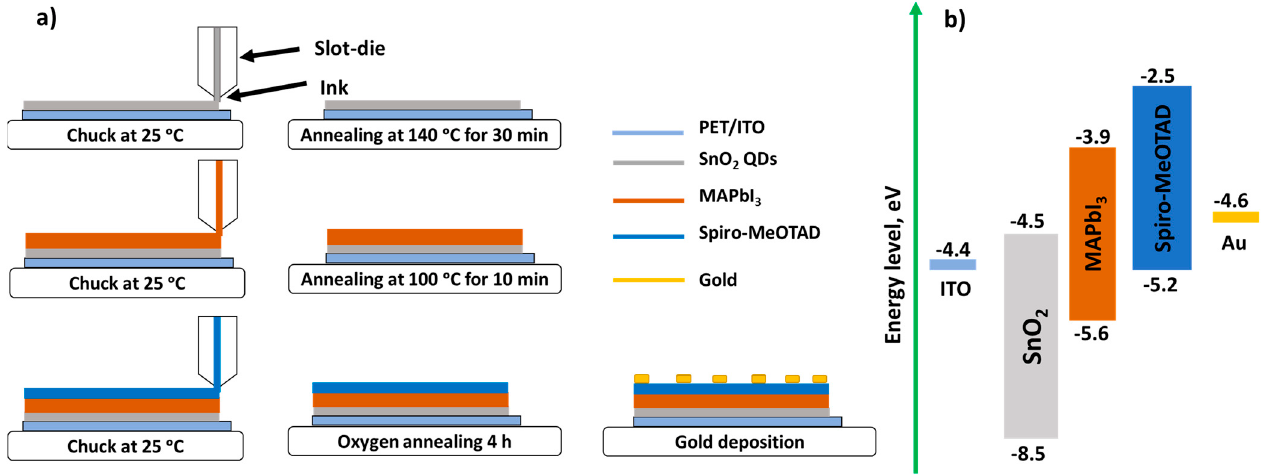
Figure 2. ( a ) Schematic diagram of the device fabrication process. ( b ) Energy level diagram for PSCs.